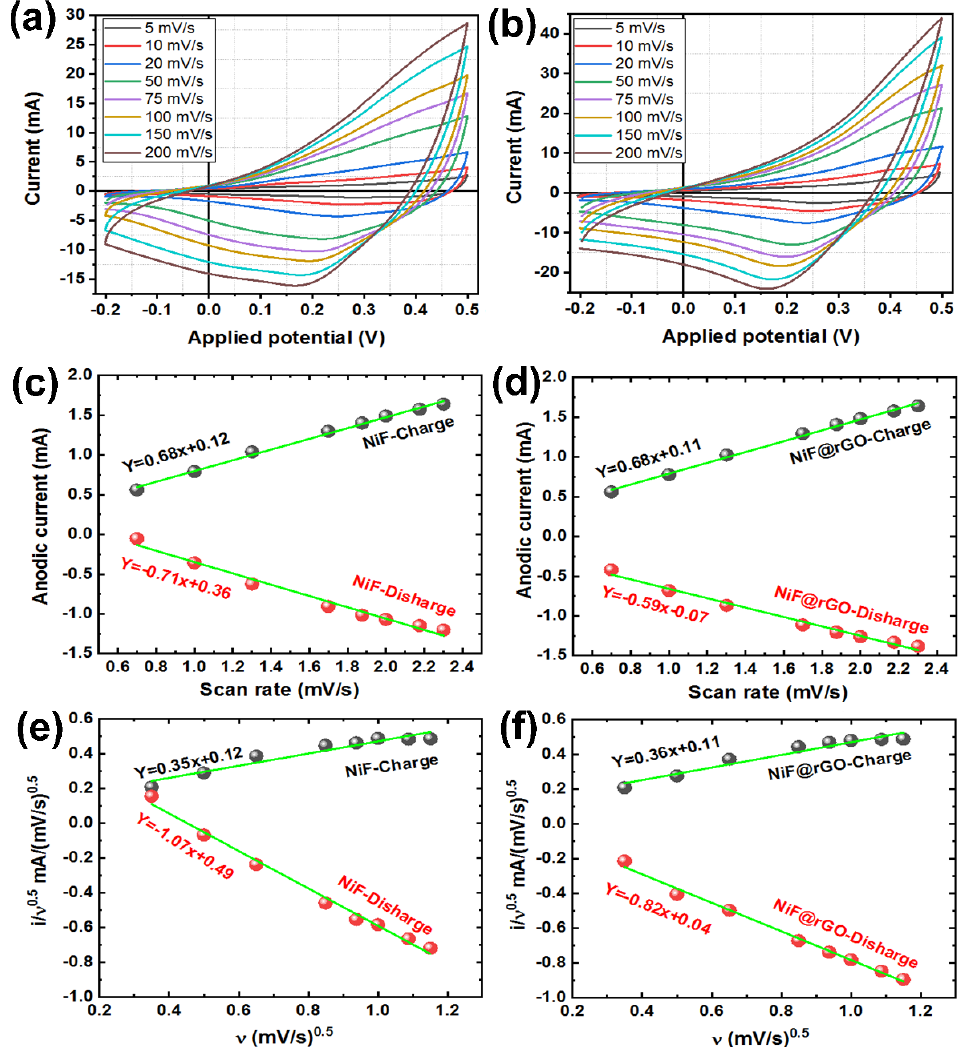
Figure 8. CV curves and the logarithmic dependence of current on the scan rate of a typical Co x NiV y O z -based electrode coated on ( a , c , e ) Ni foam and ( b , d , f ) Ni foam@rGO substrate tested in KOH electrolyte (1.0 M) at scan rates ranging from 5 to 200 mV/s.